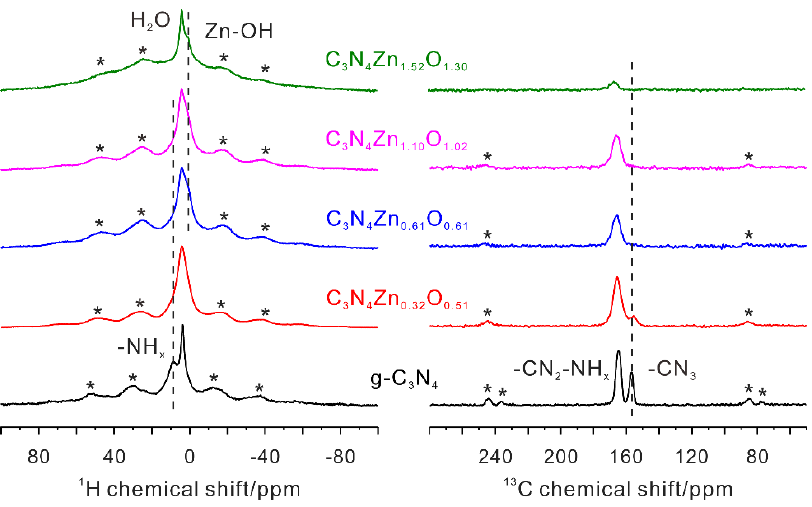
Figure 5. 1 H and 13 C NMR spectra of g-C 3 N 4 , C 3 N 4 Zn x O y , and ZnO samples. The spectra were obtained at a MAS spinning rate of 8 kHz and the symbol * represents the spinning sidebands. The chemical shifts of the spectra were calibrated according to adamantane ( 1 H 1.46 ppm, 13 C 38.56 ppm).